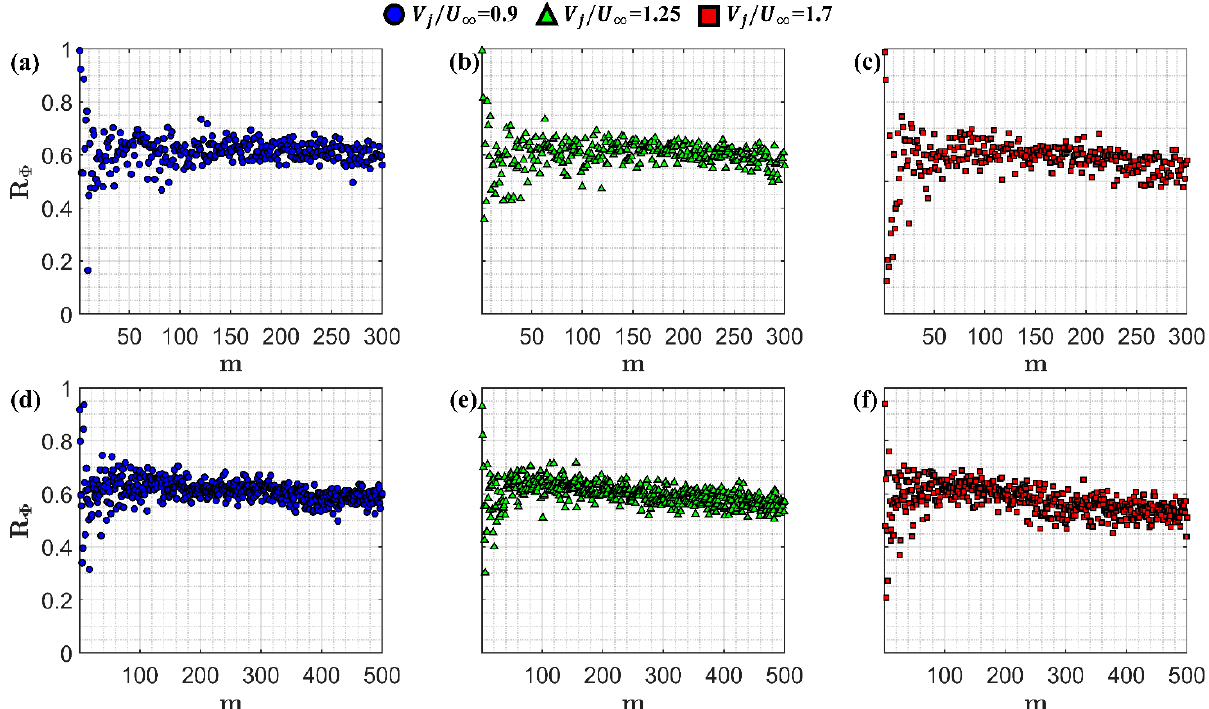
Figure 7. Composite-measured eigenvector correlations for the low-order modes of ( a – c ) U(x,z, t) and ( d – f ) W(x,z, t) velocity fields, respectively, at each velocity ratio.